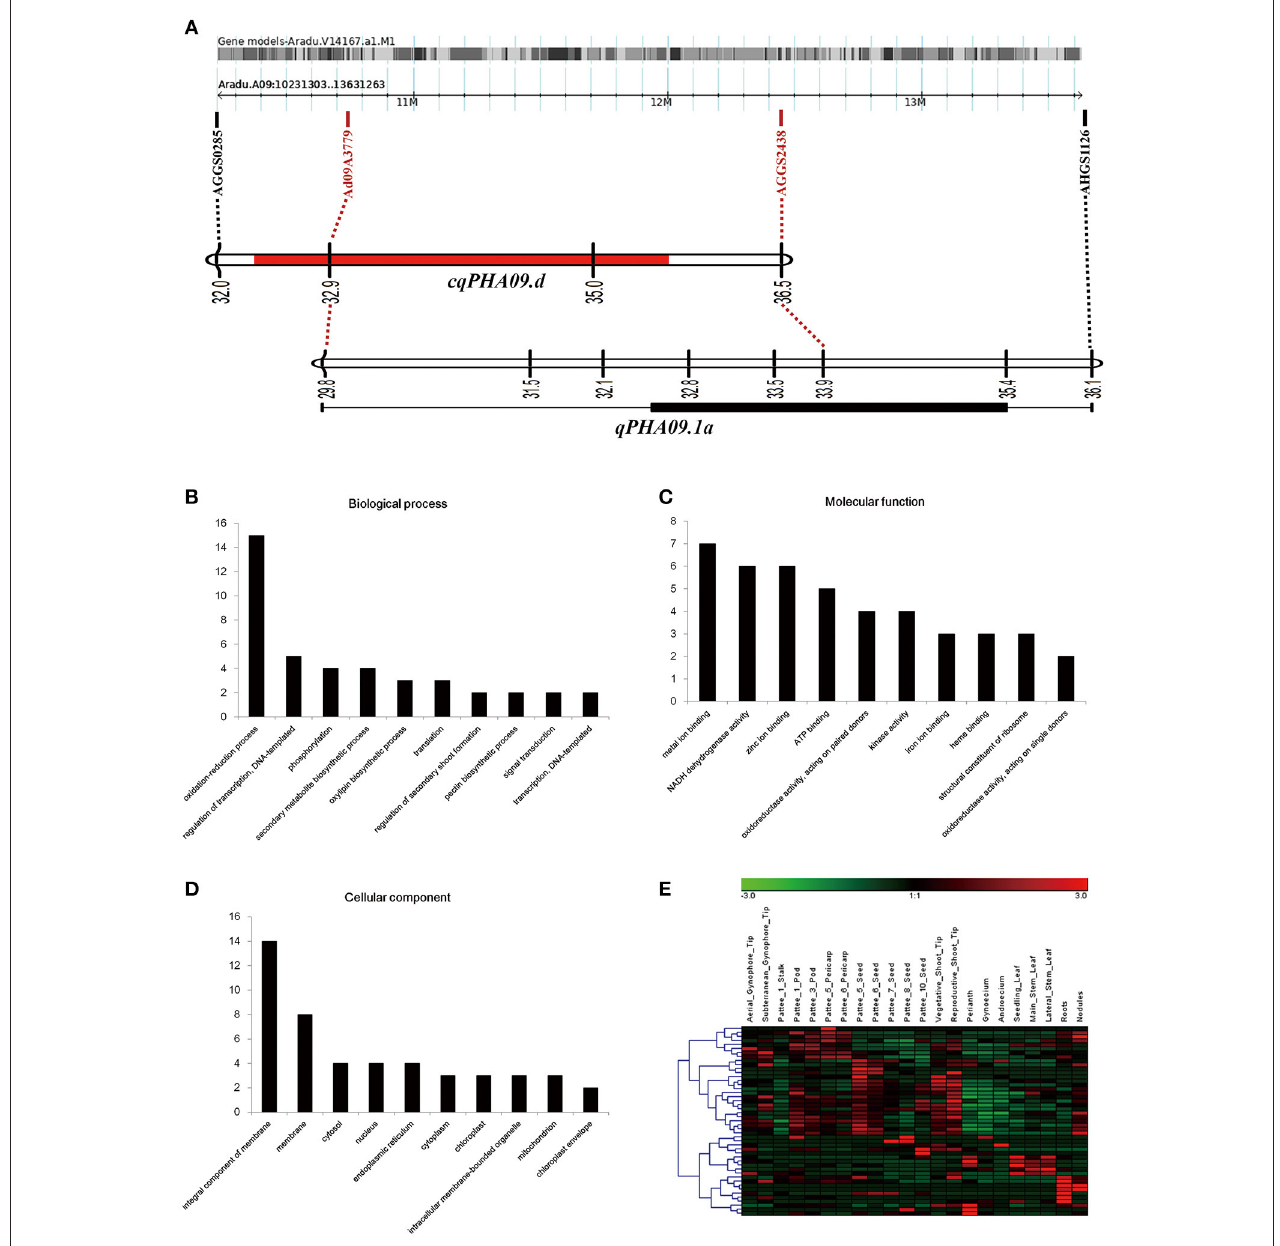
FIGURE 4 | Overview of genetic and physical co-localized region on chromosome A09. (A) Genetic linkage groups mapping on physical chromosome A09. (B–D) The top ten terms of GO annotation among biological process (B) , molecular function (C) and cellular component (D) . (E) Hierarchical clustering of expression pattern in different organisms of the cultivated peanut. The values of transcript abundance were taken from (Clevenger et al., 2016).